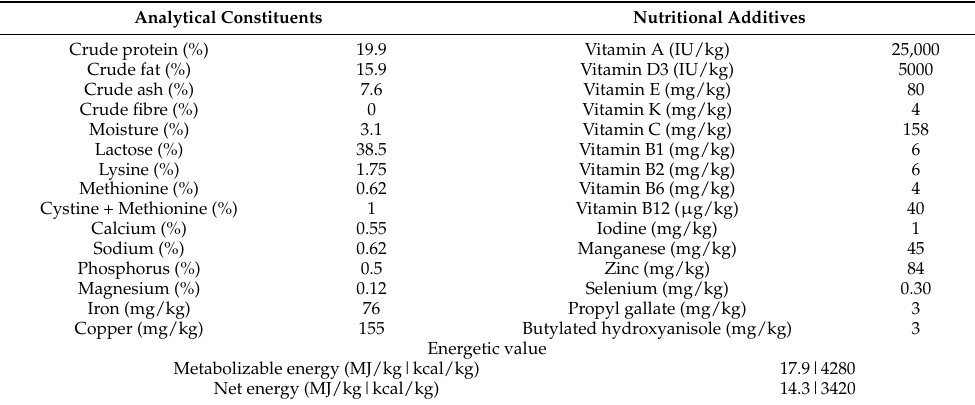
Table 2. Nutrient, chemical, and energetic composition of the supplemented milk